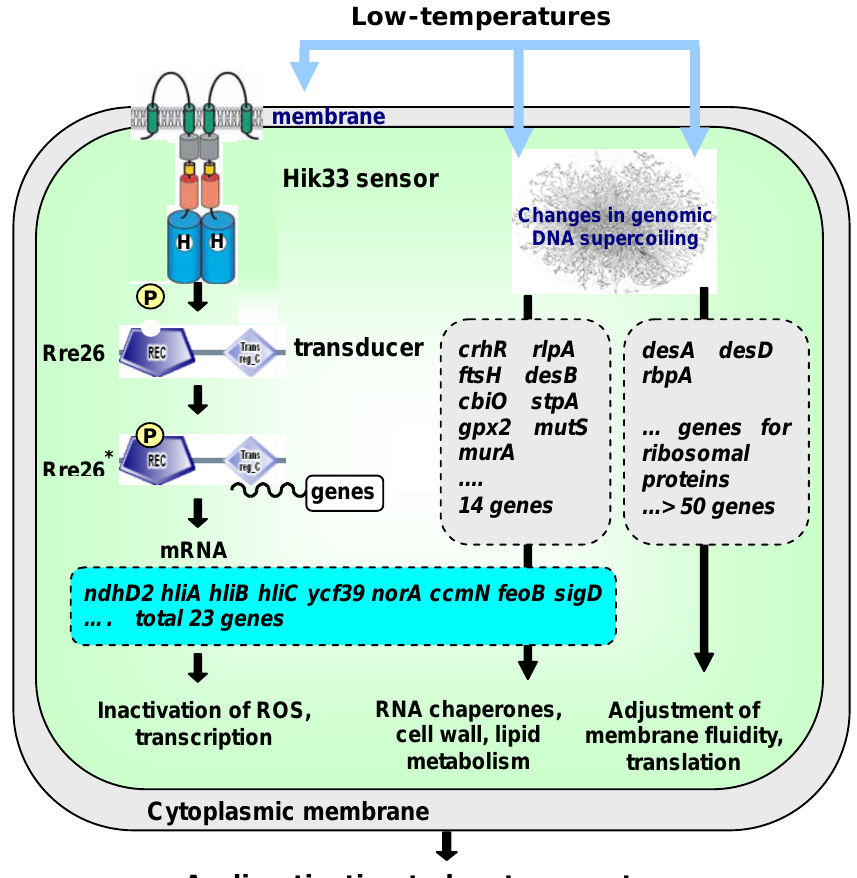
Figure 8. A scheme of the perception and transduction of cold-stress signals by cyanobacterial cells. The sensory histidine kinase Hik33 perceives the temperature-induced rigidification in the cytoplasmic membrane. Upon autophosphorylation of the Hik33 dimer, it tranduces the phosphoryl group to the response regulator Rre26, which binds to promoter region of the genes to induce their transcription. The Hik33-Rre26 two-component sensor and transduction system regulates a part of cold-inducible genes. This part, however, is also under control of the cold-induced increase in negative supercoiling of the genomic DNA. The latter mechanism controls cold-induced transcription of genes for RNA chaperons, translation, cell wall metabolism, and regulation of the membrane